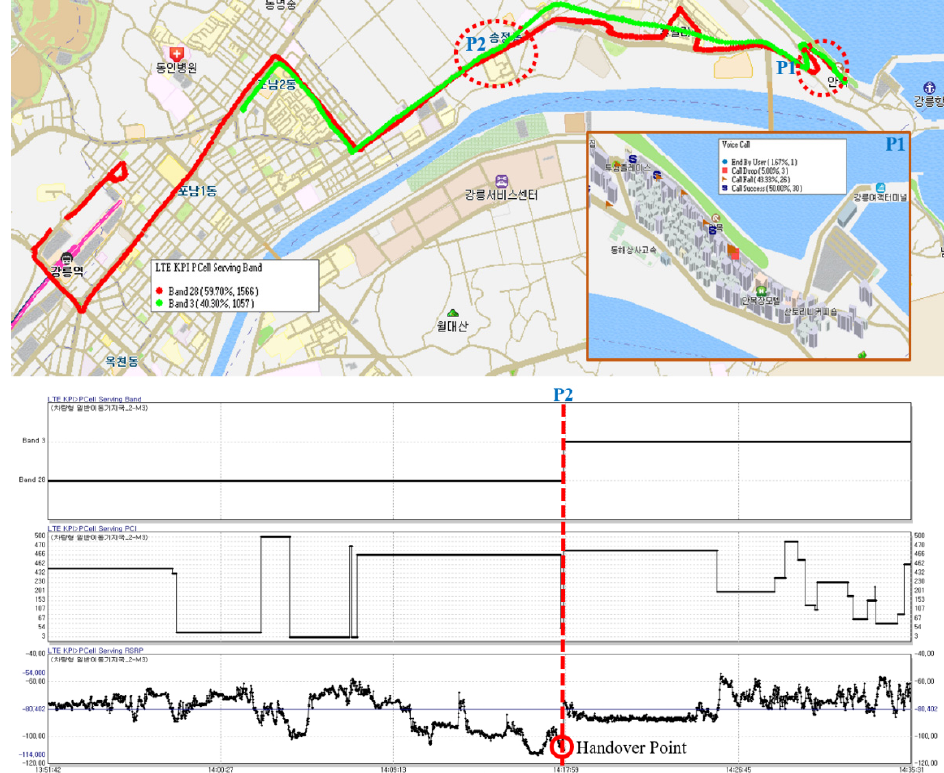
Figure 12. Analysis of RAN sharing items.